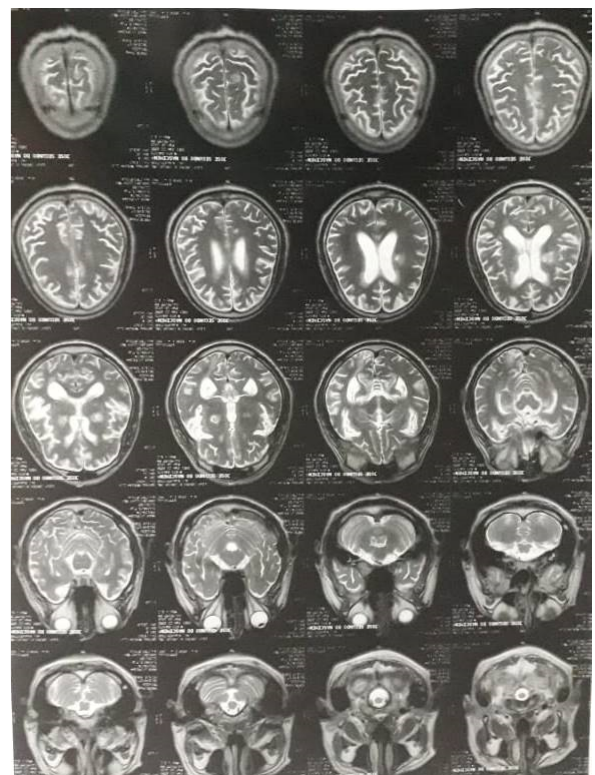
Figure 2. JS’s most recent neuroimaging scan, from January 2020, confirms most of the above findings but diverges in key points. The new exam localizes most of the extensive damage to the parietal, temporal and occipital areas on the left hemisphere, with smaller bilateral lesions to the cortical-subcortical connections mostly localized to the frontal region and basal ganglia. Additionally, there are hypersignal focus on TR sequences diffused throughout the white matter, a suggestion of microangiopathy not identified in previous exams. The diagnostic impression suggests that the damage to parietal, temporal and occipital areas on the left hemisphere is likely ischemic in origin and pre- infectious, with the damage to the basal ganglia and the cortical-subcortical transitions being possible consequences of the cerebral toxoplasmosis infection.